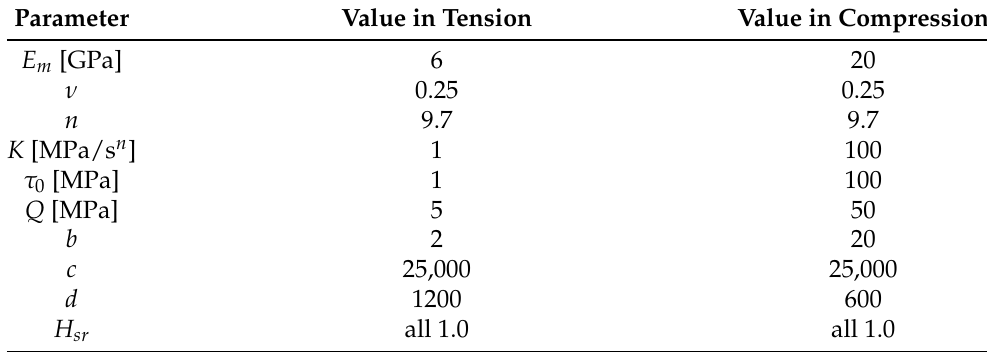
Figure 10. Difference between the cast iron model behavior for graphite without and with intro- duced plasticity. Table 2. Material parameters of